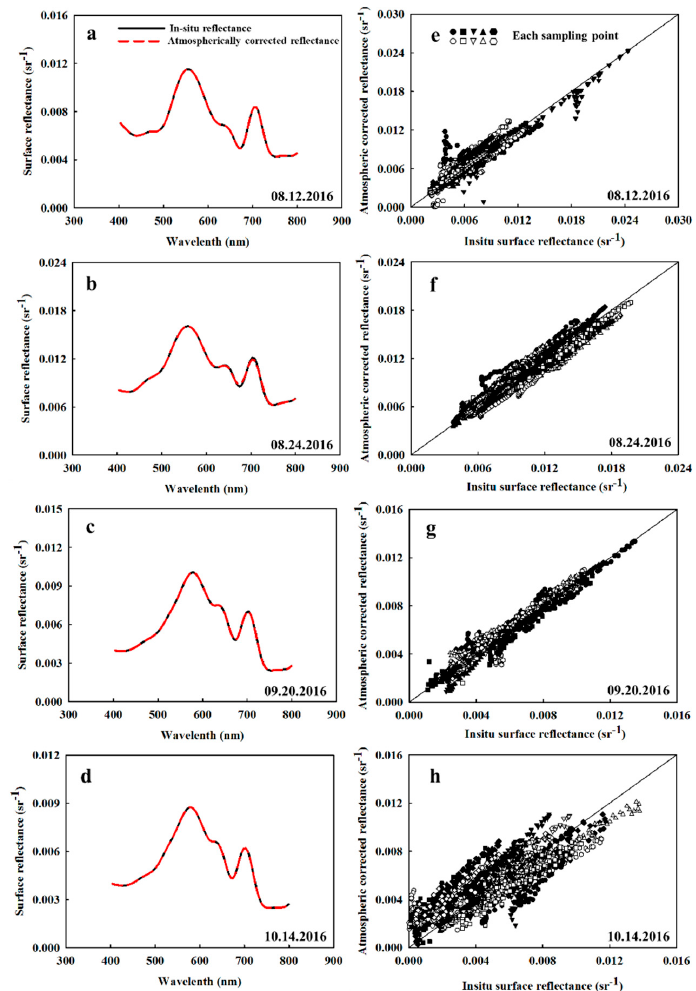
Figure 4. Atmospheric correction results using MODTRAN 6. Panels ( a – d ) show the average in-situ and corrected surface reflectance ρ surf , respectively. Panels ( e – h ) show the correlation between the observed and corrected results at different wavelengths for each sampling